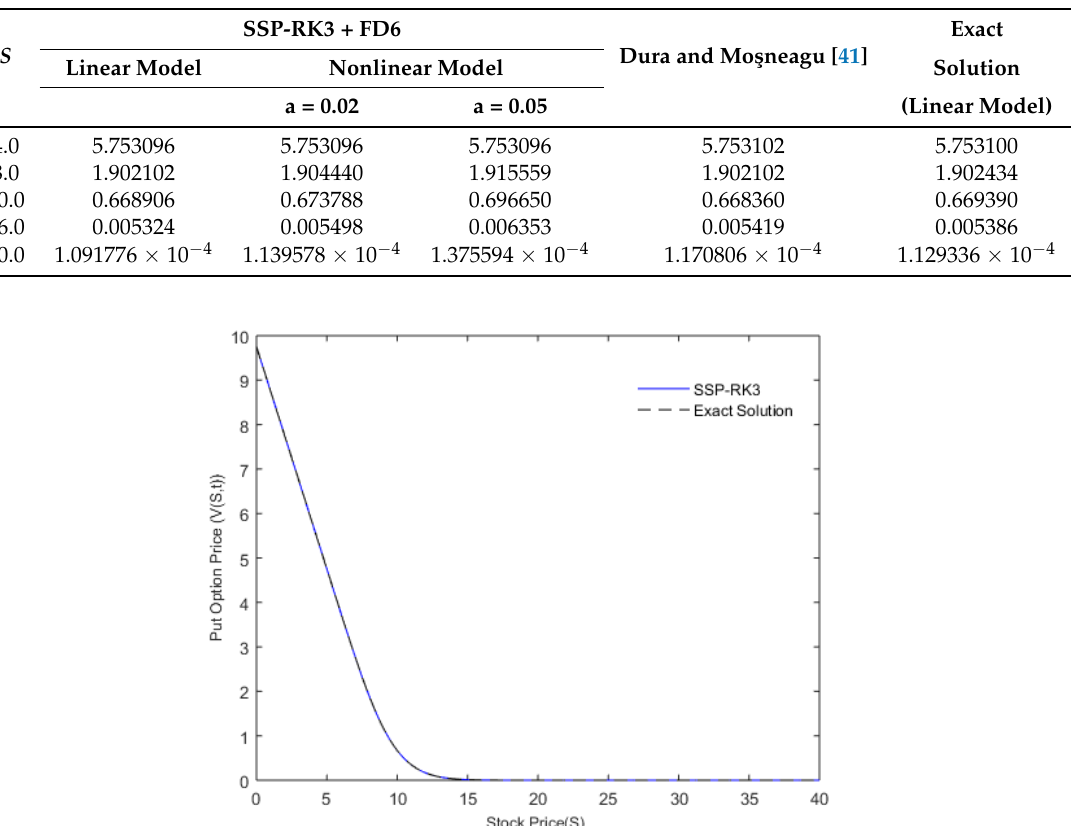
Table 1. Comparison between exact and numerical solutions of the linear and nonlinear European put option model for various stock price values at t = 0.